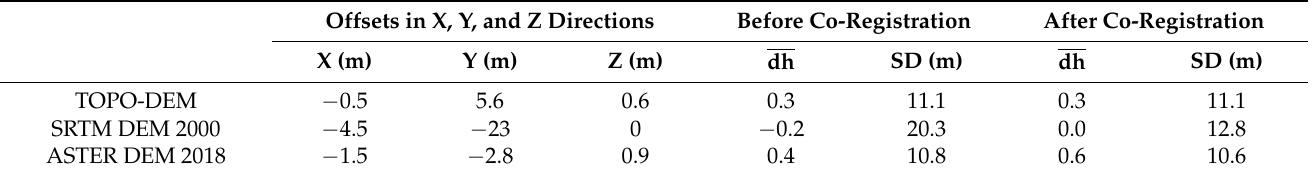
Table 2. The offsets in X, Y, and Z directions in the DEM dataset and the uncertainty in DEMs before and after